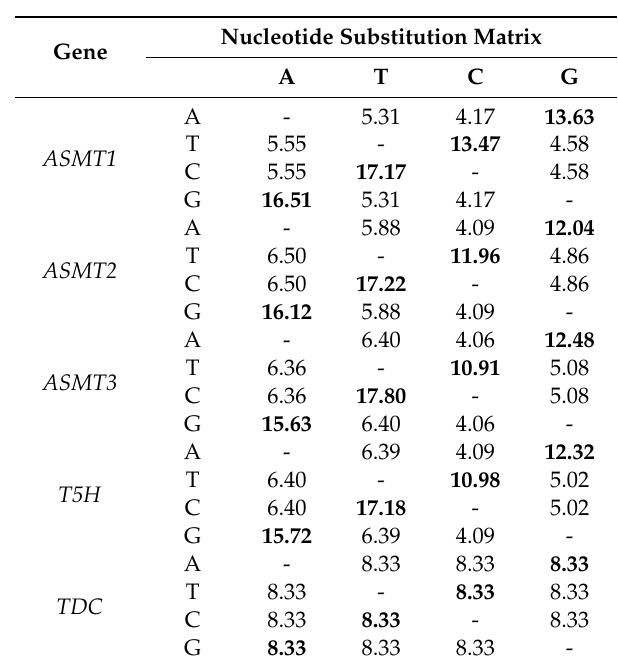
Table 1. Description of the maximum likelihood estimate of the pattern of nucleotide substitution in the five melatonin biosynthesis genes. Each entry is the probability of substitution from one base (row) to another base (column). Rates of di ff erent transitional substitutions are shown in bold and the rest for transversional